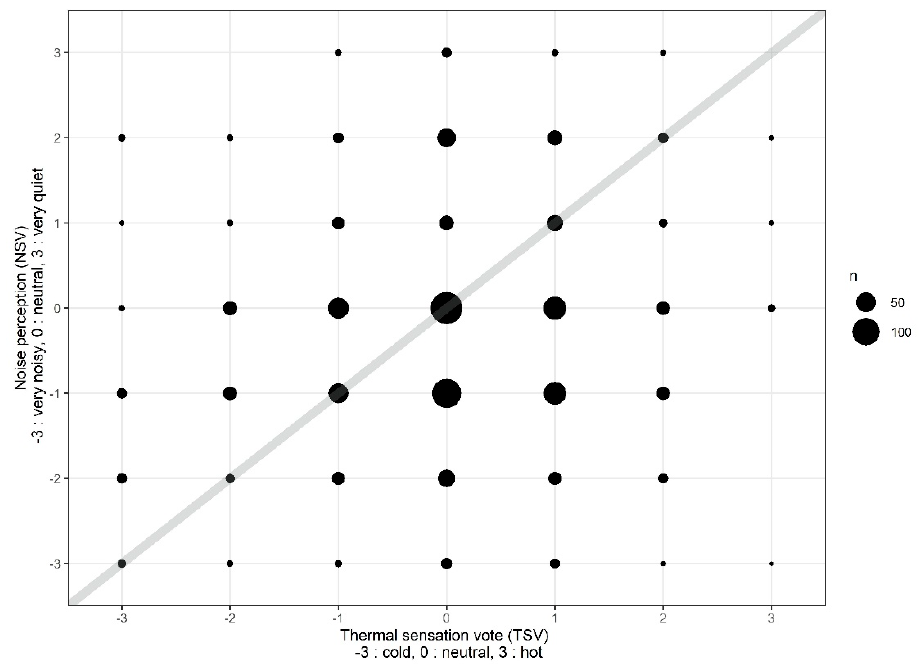
Figure 6. Comparison of agreement between thermal and noise perception vote results for Stage 2 (the number of responses n is proportional to the area of circles).